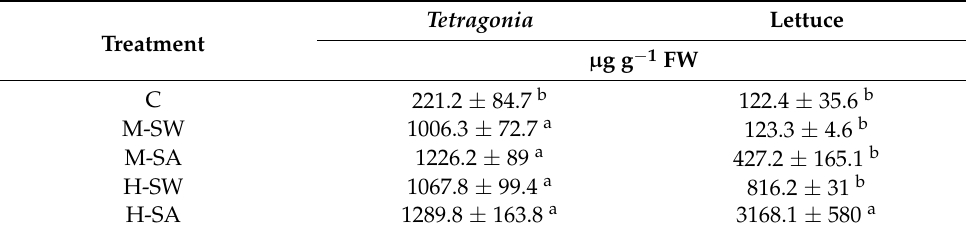
Table 5. Proline concentration in the edible